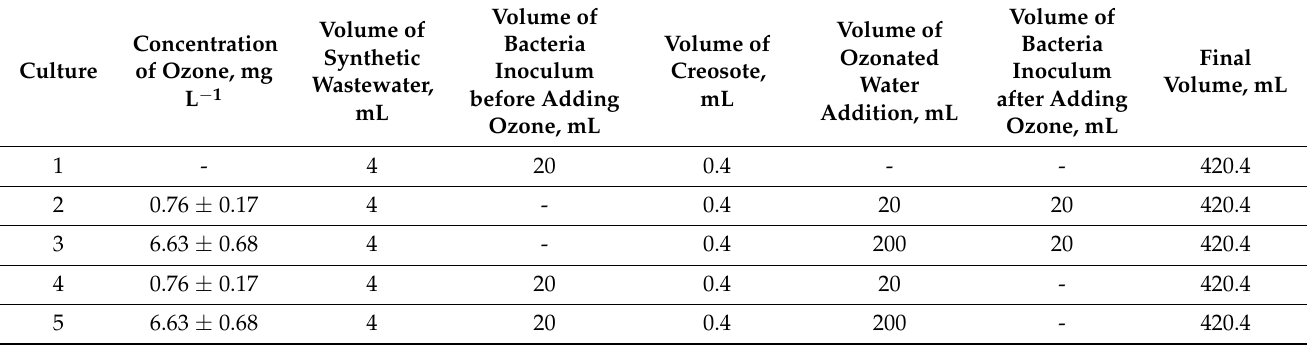
Table 1. Procedure of culture